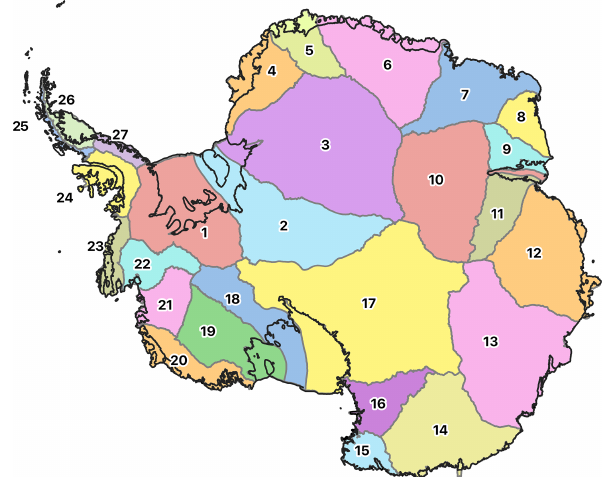
Figure A5. Labeled AIS drainage basins (Zwally et al., 2012).